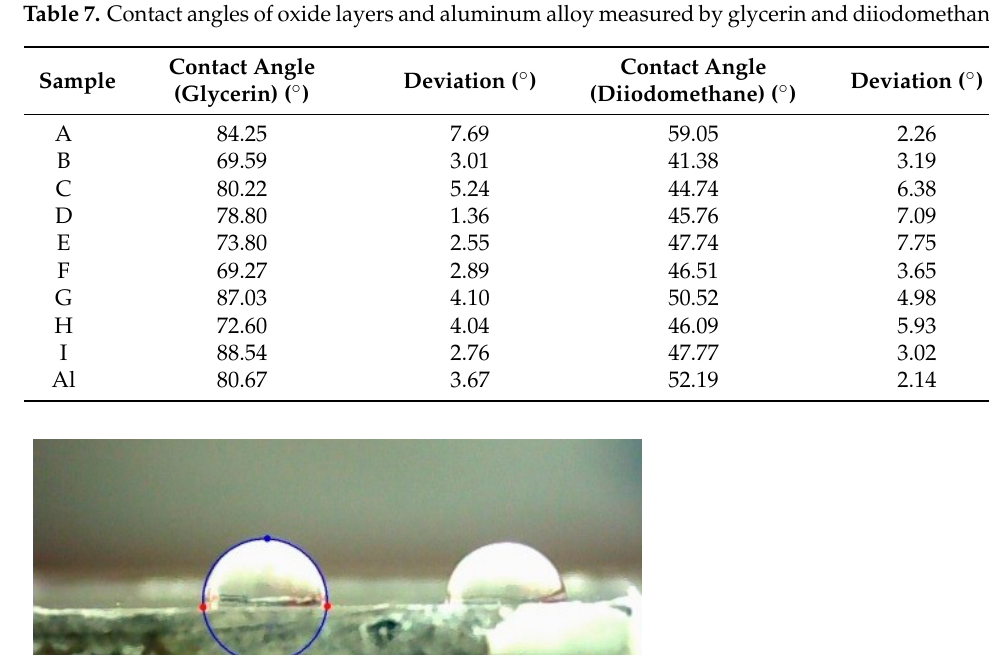
Figure 15. Roughness profiles: ( a ) sample C, ( b ) sample G, 1 —before the tribological test, 2 —after the tribological test.